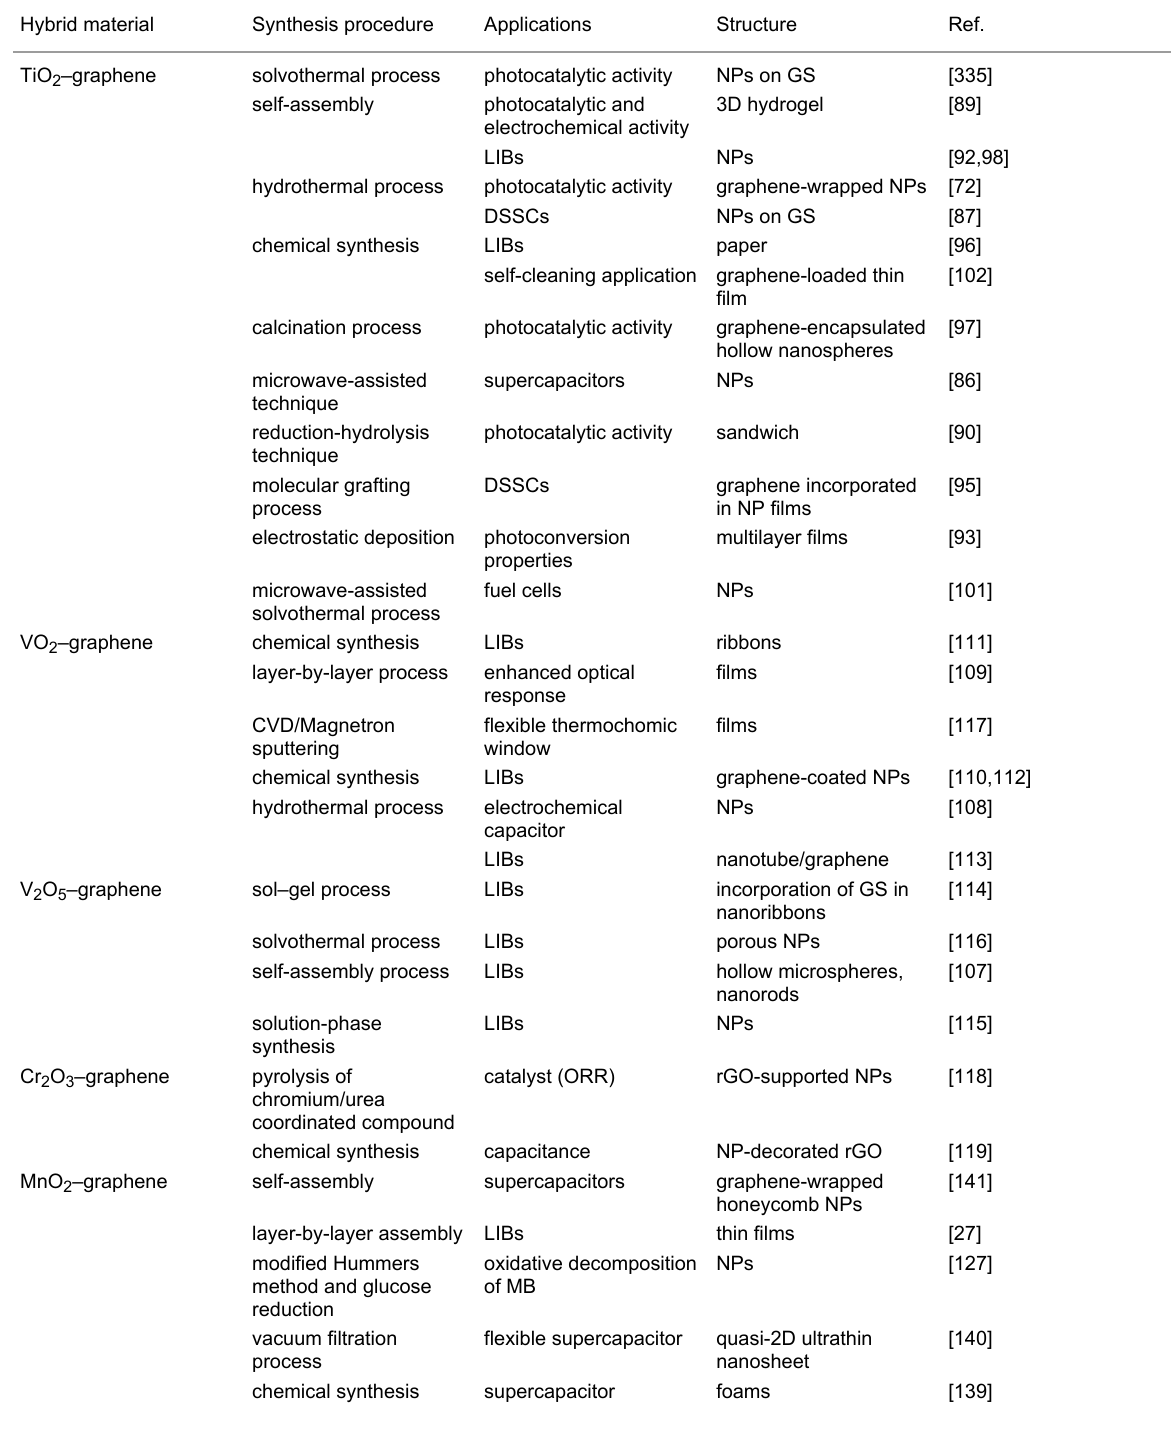
Table 1: Important hybrid material synthesis procedures and their potential applications.